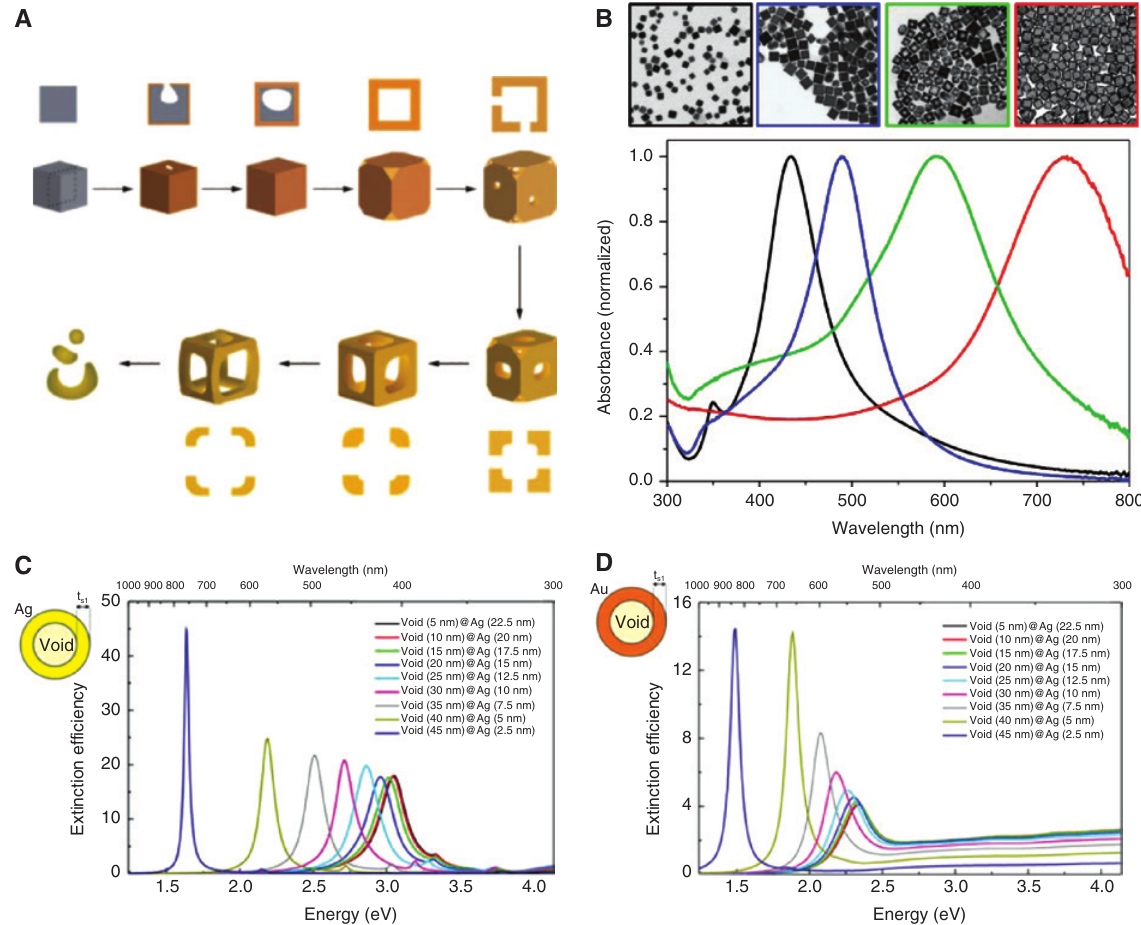
Figure 2: The mechanism of void formation during GRR reaction and its effects on optical properties. (A) Schematic illustration of the morphological and structural changes involved in the GRR between a silver nanocube and HAuCl . The cross-sectional views correspond 4 to the plane along the dashed lines. The major steps of the reaction include the following: formation of a pinhole at one of the side faces; continuation of the GRR resulting in a partially hollow structure; enlargement of pores at the side faces; reduction of the ridge thickness; and finally fragmentation of the nanoframes (adapted with permission from Ref. [82], through the Creative Commons Attribution Noncom- mercial License). (B) UV-Vis spectra of Ag nanocubes (in black), core-shell Ag@A unanocubes (in blue), pinholed AuAg nanoboxes (in green) and single-walled AuAg nanoboxes (in red) along with their representative TEM images, revealing the shift of plasmon resonances with the formation of hollow nanostructures. (C) and (D) are the Mie scattering calculations revealing the effect of void size on the optical properties 50 nm Ag and Au nanospheres,